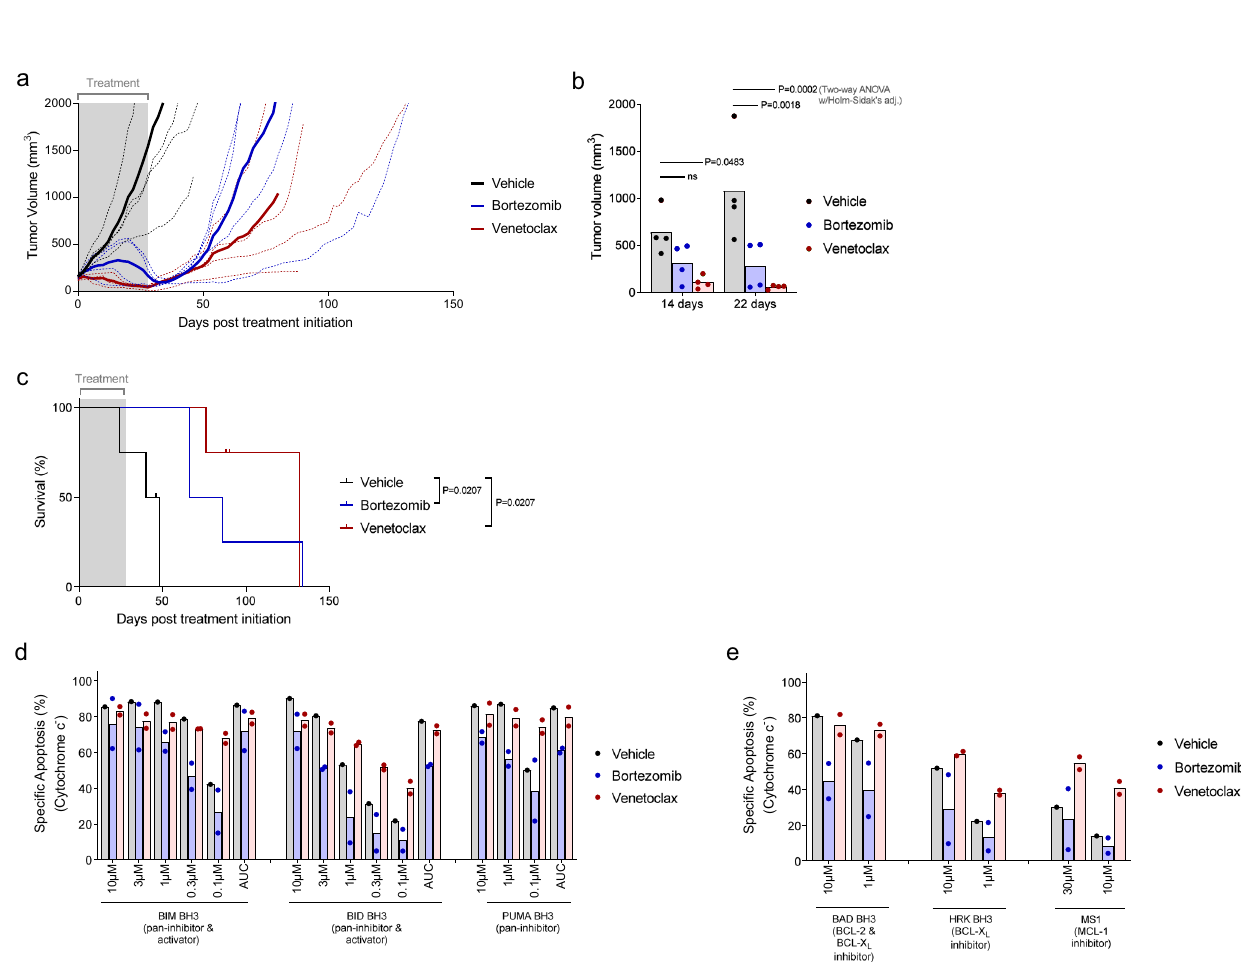
Fig. 4 | AL amyloidosis cell line ALMC-1 is sensitive to BCL-2 and MCL-1 inhi- bition while multiple myeloma cell line ALMC-2 is sensitive only to MCL-1 inhibition. a , b ALMC-1 and ALMC-2 cells were BH3 pro fi led with a activator or b sensitizer peptides at indicated concentrations ( n =3). c – d ALMC cell lines were BH3 pro fi led during short-term (4h) treatment with bortezomib. Δ priming is cal- culated as the difference in treated versus untreated cells ( n =3). e – g ALMC cell lines were treated with indicated( e ) singleagents or f – g combinationsfor 12hand apoptosis was detected by Annexin V staining ( n =3). a – g Data are presented as mean values+/- SEM. h Western blotting was performed on cell lines with and